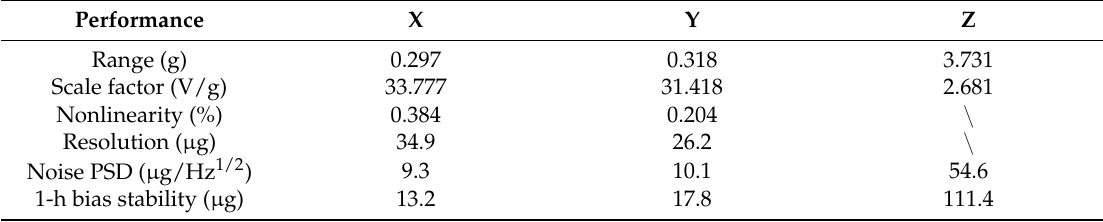
Table 5. Summary of the experimental performance.